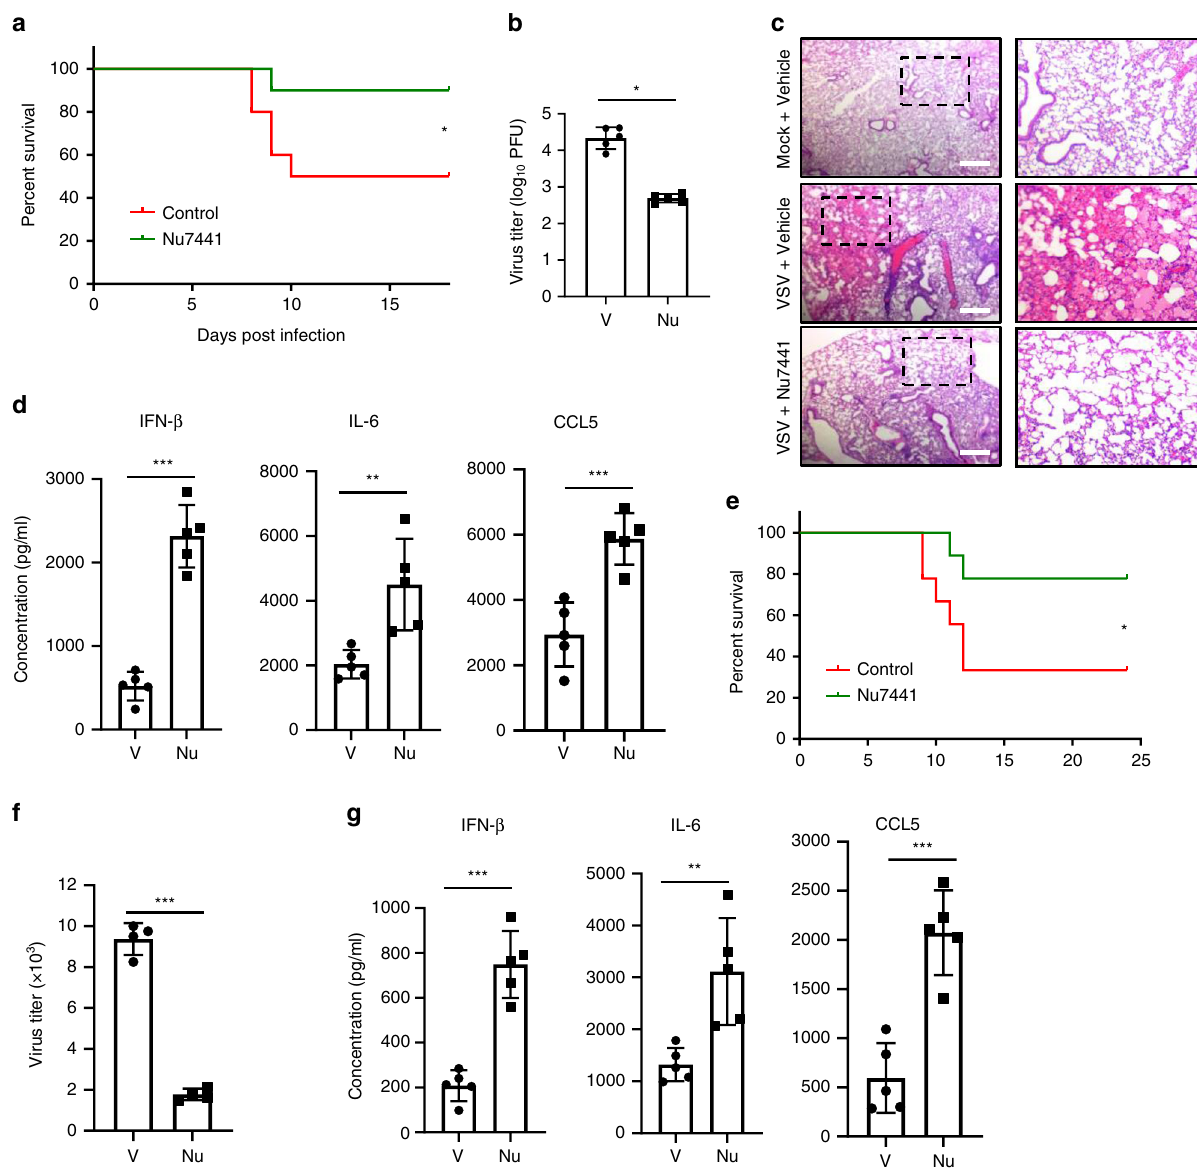
Fig. 6 Nu7441 treatment promotes antiviral innate immunity and suppresses VSV and HSV-1 replication in vivo. a – d Age- and gender-matched BL/6 mice were treated with 20 mg/kg Nu7441 or control through intraperitoneal injection and infected with VSV (10 8 PFU). a Mouse survival was recorded and shown as percentage over time ( n = 10 biologically independent animals, p = 0.046). b Mice were sacri fi ced at 3 days post-infection, and viral titers in the spleens were quanti fi ed by plaque assays ( n = 5 biologically independent animals, p = 3 × 10 − 6 ). c H&E-stained lung sections from the indicated mice 3 days post-infection. (Scale bar = 200 μ m). d Blood was collected at 6 h post-infection, and the indicated cytokines in sera were determined by ELISA ( n = 5 biologically independent animals, p = 1 × 10 − 5 (IFN- β ); p = 0.0060 (IL-6); p = 0.0008 (IL-6)). e , g Age- and gender-matched BL/6 mice were treated with 20 mg/kg Nu7441 or control through intraperitoneal injection and infected with HSV-1 (5 × 10 7 PFU). e Mouse survival was recorded and shown as percentage over time ( n = 9 biologically independent animals, p = 0.045). f Mice were sacri fi ced at 3 days post-infection, and viral titers in the brains were quanti fi ed by plaque assays ( n = 4 biologically independent animals, p = 2 × 10 − 6 ). g Blood was collected at 6 h post-infection, and the indicated cytokines in sera were determined by ELISA ( n = 5 biologically independent animals, p = 8 × 10 − 5 (IFN- β ); p = 0.0060 (IL-6); p = 0.0004 (IL-6)). All experiments were done at least twice, and one representative is shown. For b , d , f , g , data are presented as mean values ± SD. * p < 0.05, ** p